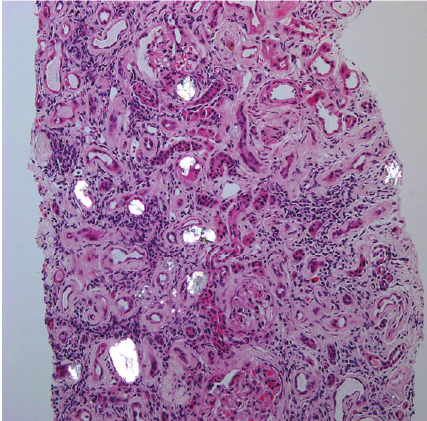
Figure 1: Hematoxylin and eosin stain of renal biopsy under polarized light (20x magnification) showing oxalate crystals in tubular lumen.